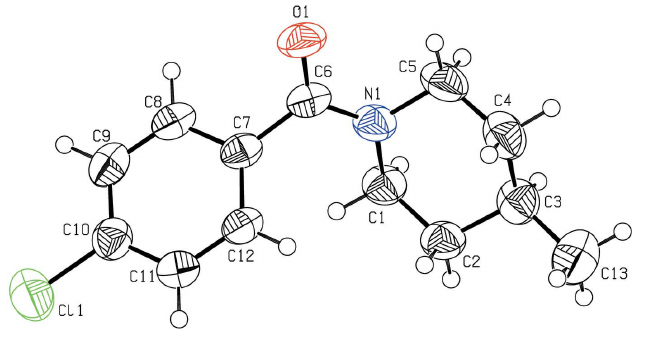
Figure 1 The molecular structure of the title compound showing the atom- labelling scheme with displacement ellipsoids drawn at the 30% probability